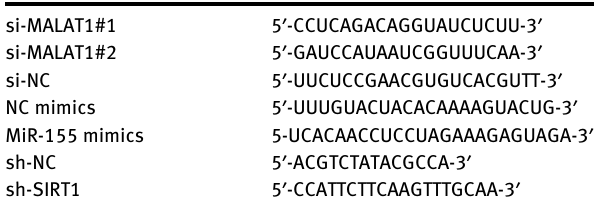
Table  : Primer sequences in cell